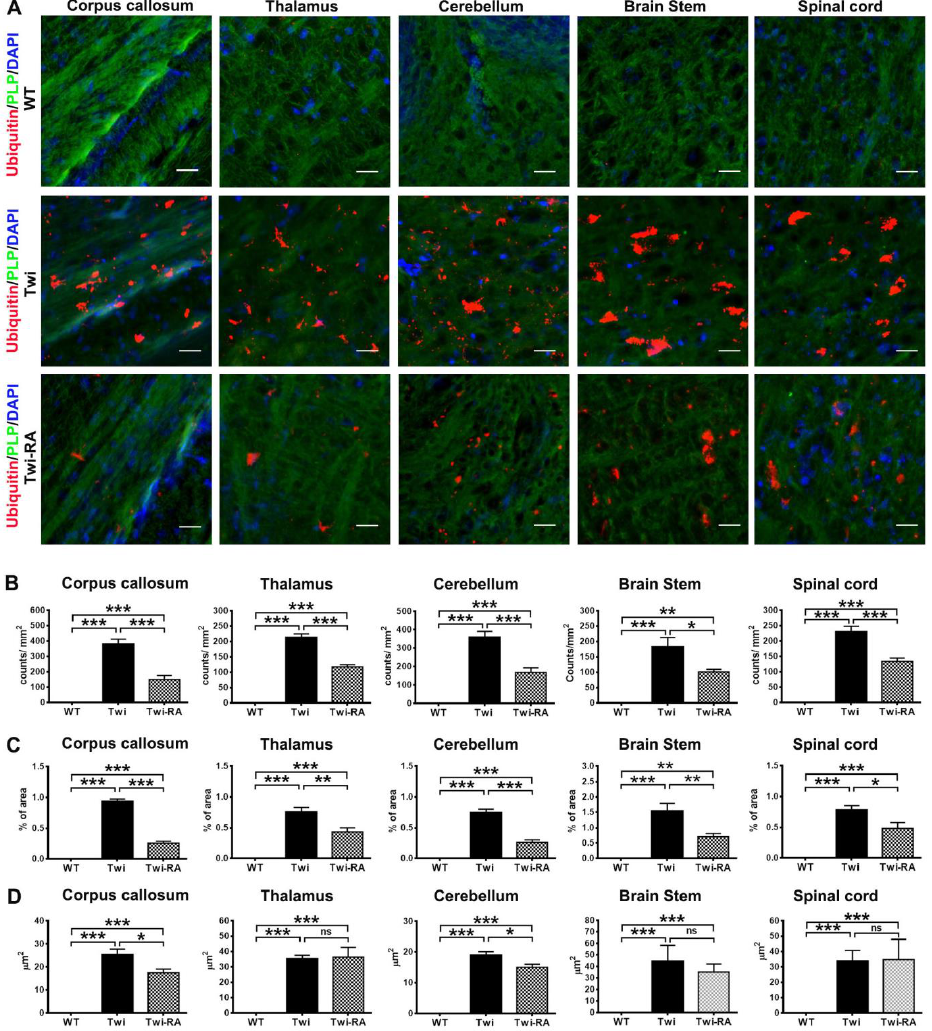
Figure 4. Accumulation of ubiquitin aggregates alleviated by rapamycin. ( A ) Representative images of ubiquitin (red), PLP (green), and nuclei (DAPI) immunostaining in different regions of the brain of wild-type (WT), untreated twitcher (Twi), and rapamycin-treated twitcher (Twi-RA) mice at 35 days of age. Scale bars: 200 μm. Total amounts of ubiquitin aggregates per square millimeters ( B ), the percentage of area occupied by ubiquitin aggregates ( C ), and the average size of ubiquitin aggregates were quantitatively analyzed with ImageJ ( D ). Values are expressed as mean ± SEM and compared using One way ANOVA (Tukey post hoc test) ( n = 5). Statistical significance, * p < 0.05, ** p < 0.01, *** p < 0.001, and ns (not